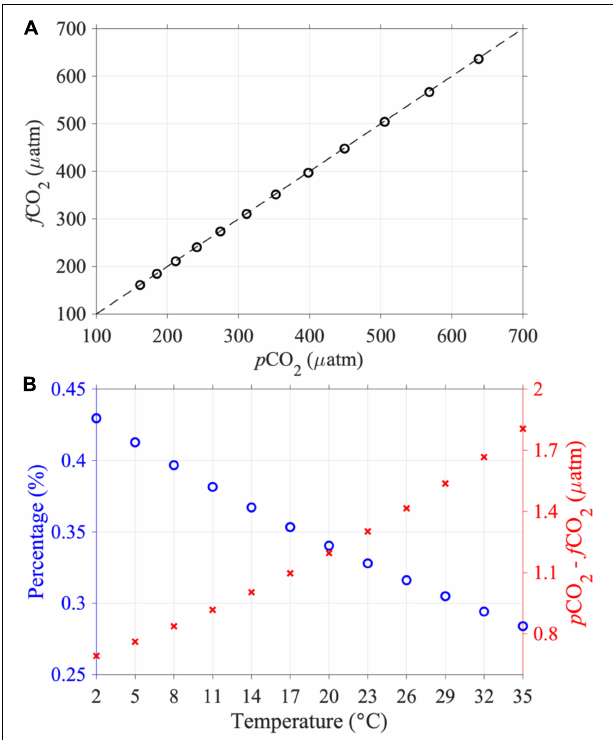
FIGURE 3 | Plot of (A) the calculated carbon dioxide fugacity ( f CO 2 ) against the calculated partial pressure ( p CO 2 ), and (B) Relative differences (blue) between p CO 2 and f CO 2 against water temperature, and their absolute differences (red), based on a CO2SYS calculation using an imaginary seawater with the global average surface ocean temperature, salinity, DIC, and TA of 19.23 ◦ C, 34.87, 2020 µ mol kg − 1 , and 2306 µ mol kg − 1 , respectively (Jiang et al., 2015b), and using the recommended constants that are given in section “Recommended Dissociation Constants and Other Values for Carbon System Calculations” of the Supplementary Material .